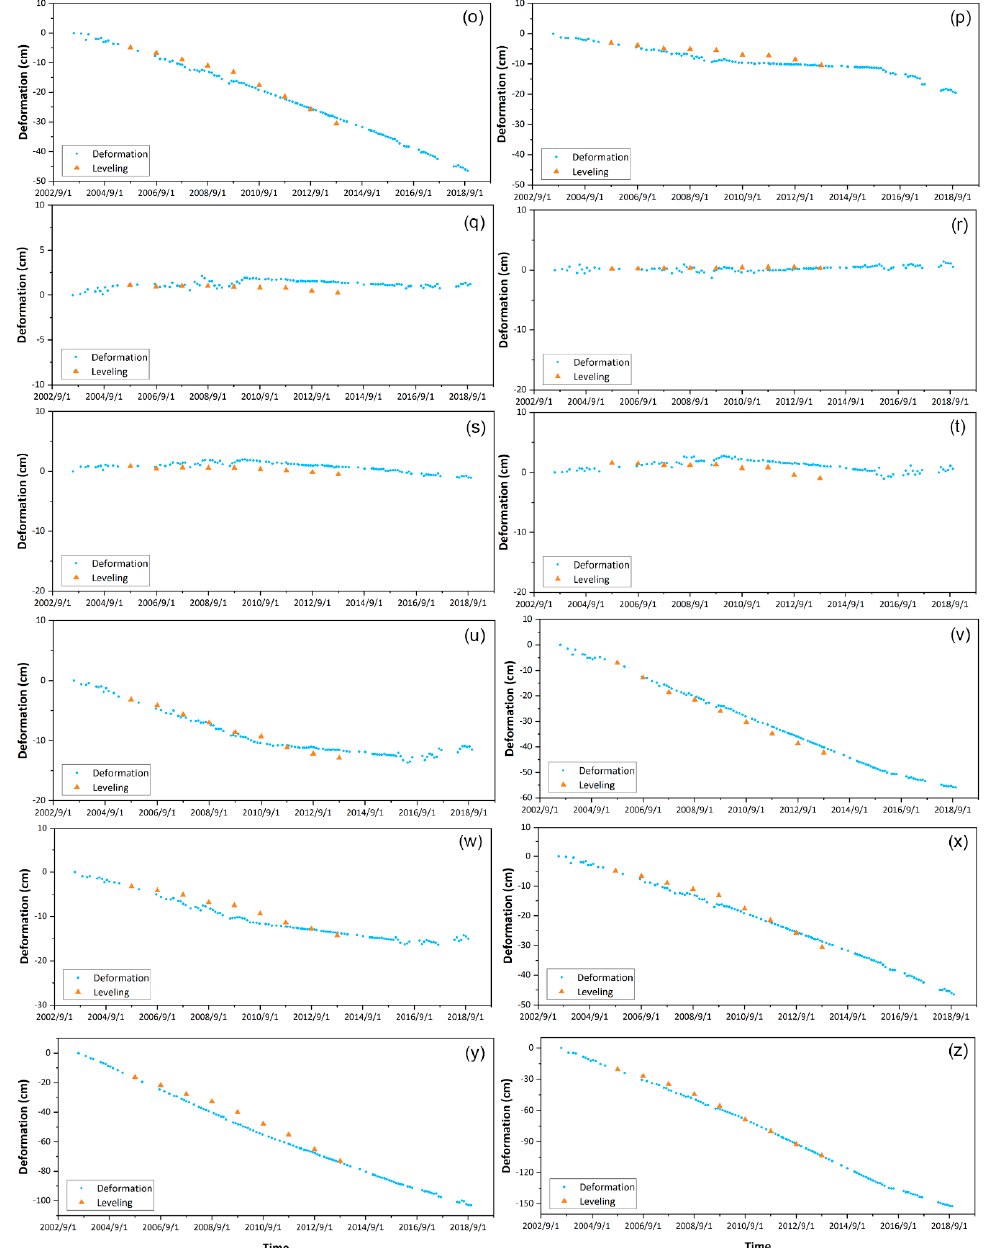
Figure 10. Time-series matching diagram of leveling and MMTI-TSF results (Part 2). The position of